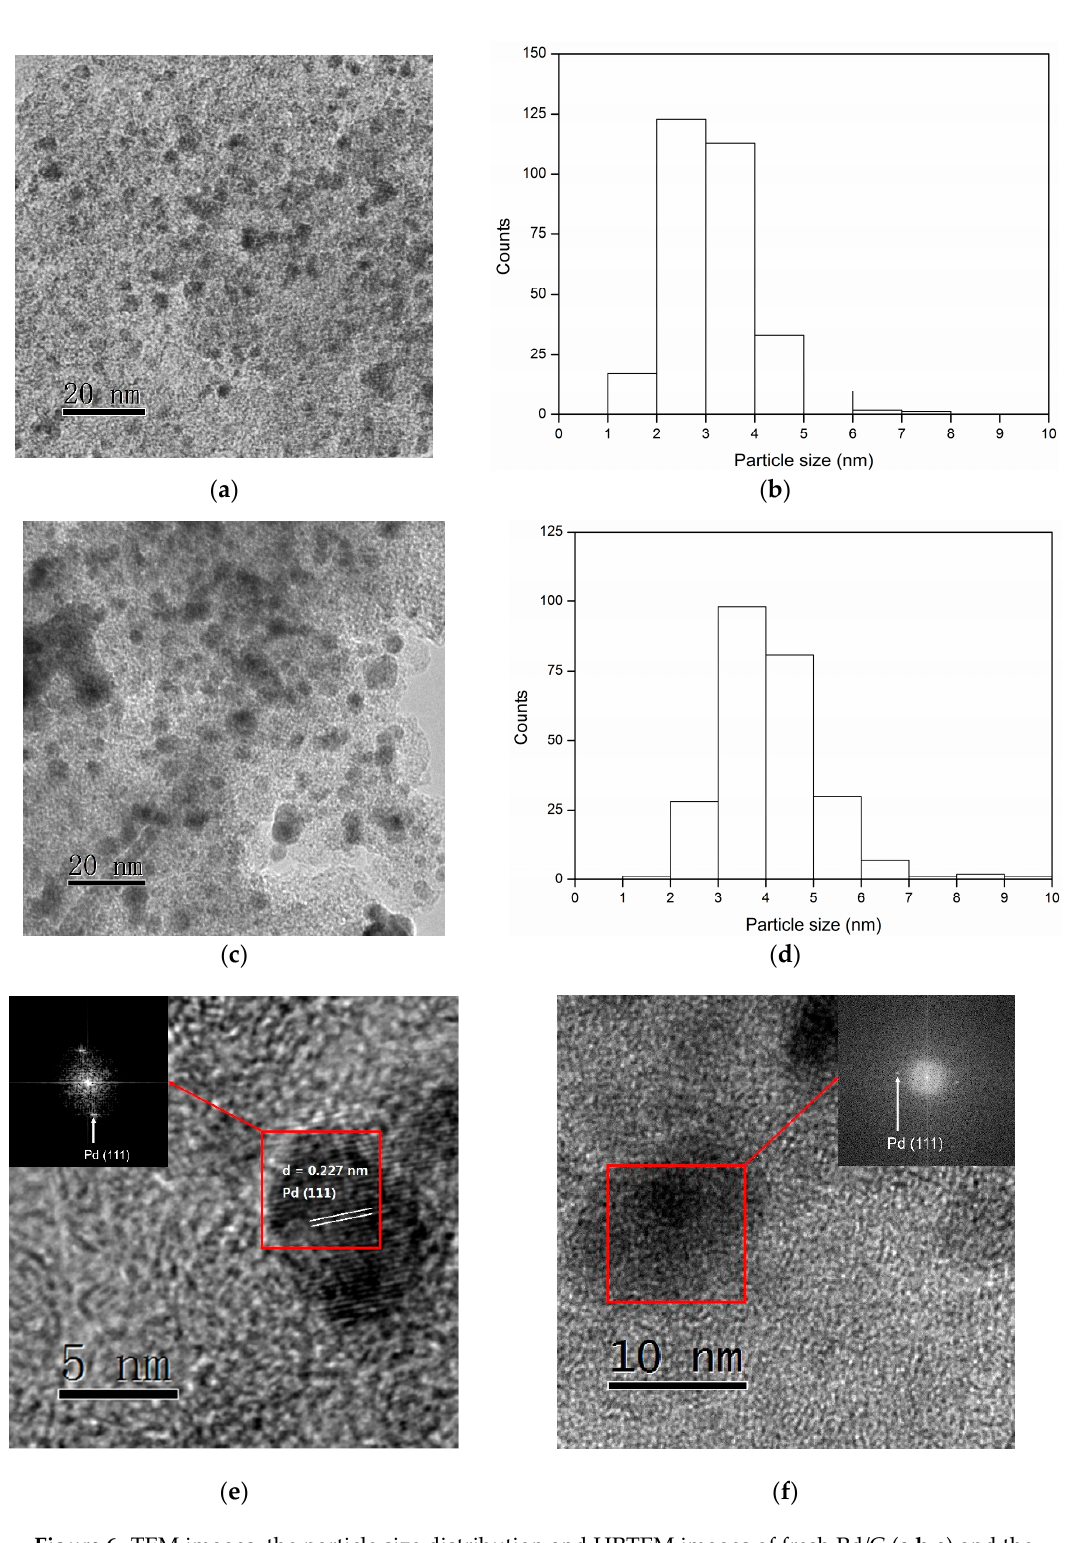
Figure 6. TEM images, the particle size distribution and HRTEM images of fresh Pd/C ( a, b, e ) and the used Pd/C ( c, d, f ). The inset in the HRTEM image is the diffraction spots after fast Fourier transform.